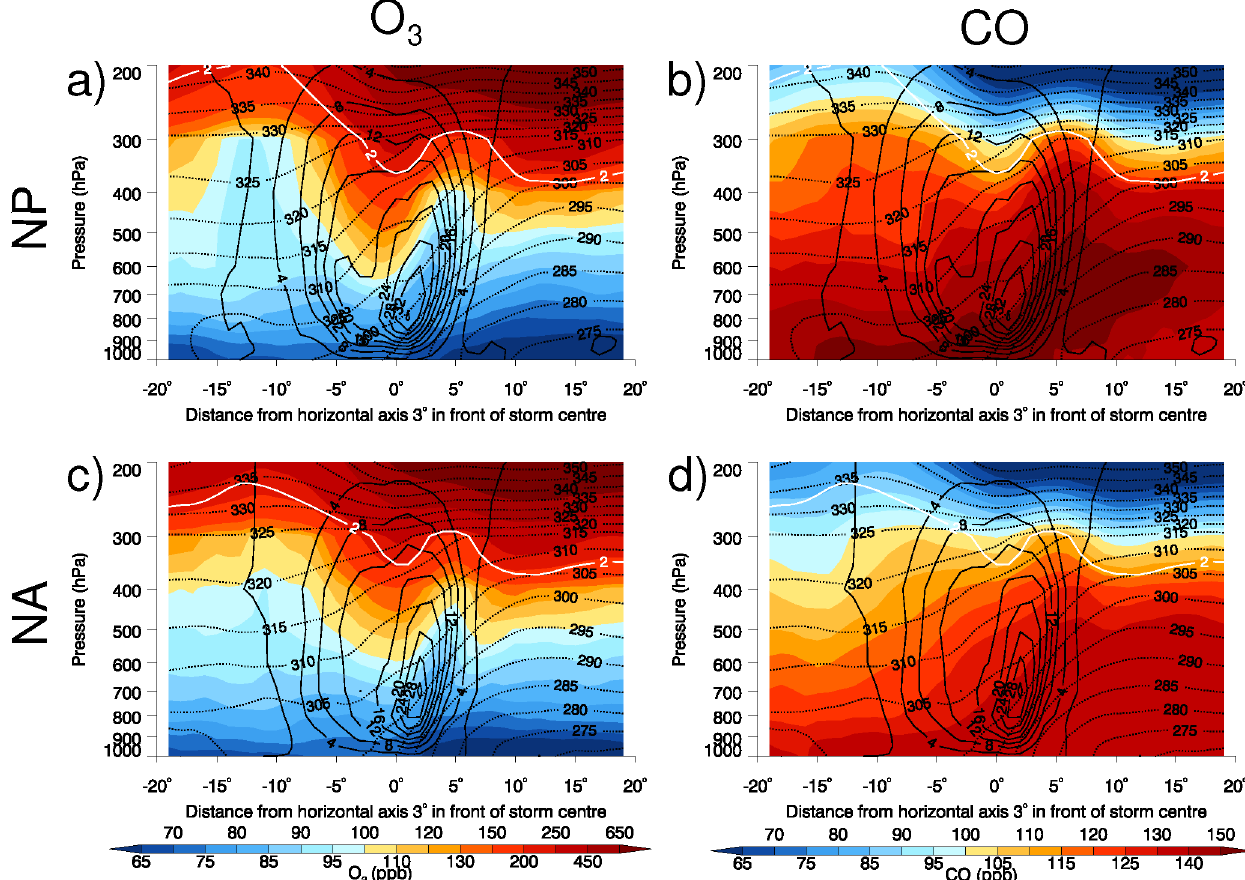
Figure 8. Vertical cross sections of the storm-centered composite for (a, b) NP and (c, d) NA 95th percentile MAM storm tracks during 2003–2012 for the WCB, 3 ◦ to the right of storm center. (a, c) O 3 and (b, d) CO (ppb) with θ e (dotted contour lines, 5K intervals), ω (solid contour lines; 4hPah − 1 contour intervals, with positive values indicating ascent), and the isosurface of 2 PVU (solid white line) are